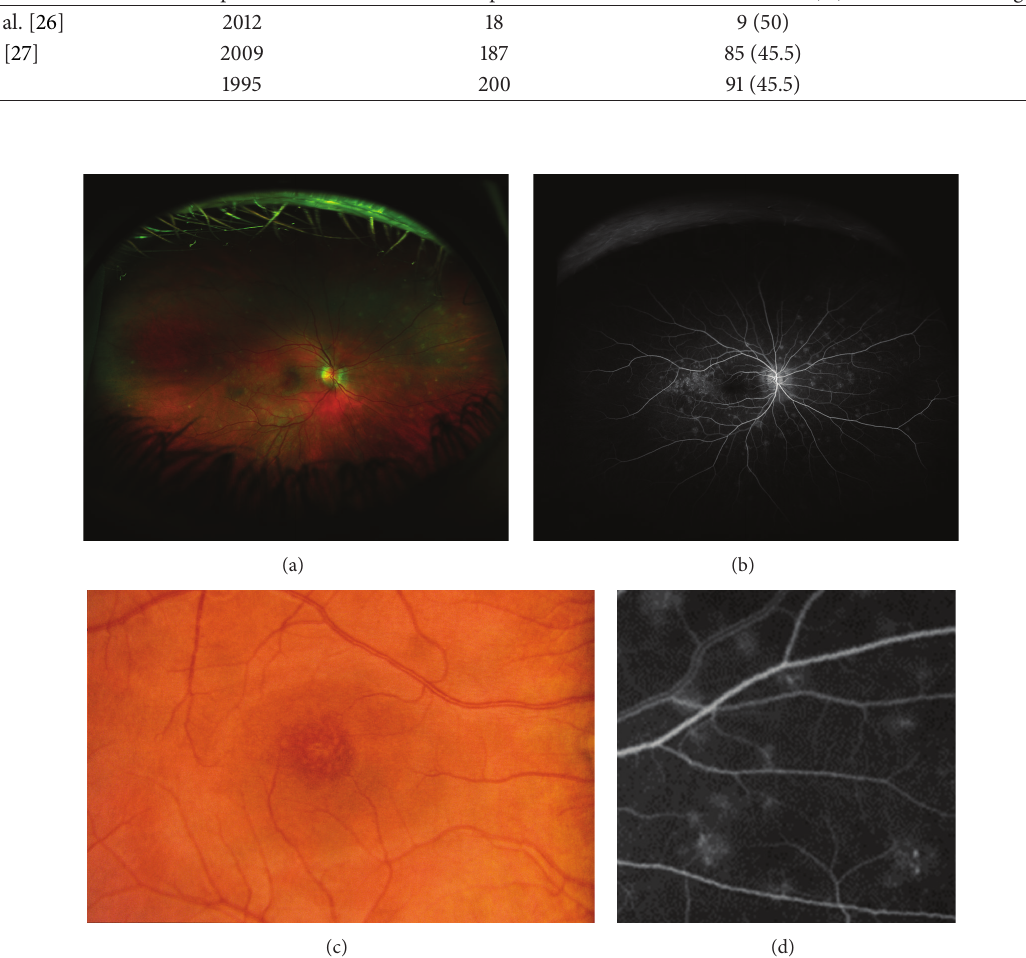
Figure 3: (a) Fundus photograph and corresponding (b) fluorescein angiogram (FA) demonstrating classic wreath-like patterns in MEWDS. (c) Fundus photograph of the macula of different patient demonstration foveal granularity and (d) magnified view of the wreath-like patterns seen on FA in